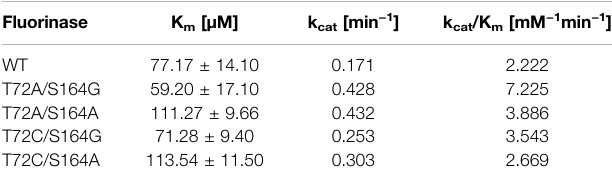
TABLE1| ComparativekineticsdataofFamandthevariantsfortheconversionof SAM into 5 ′ -FDA a